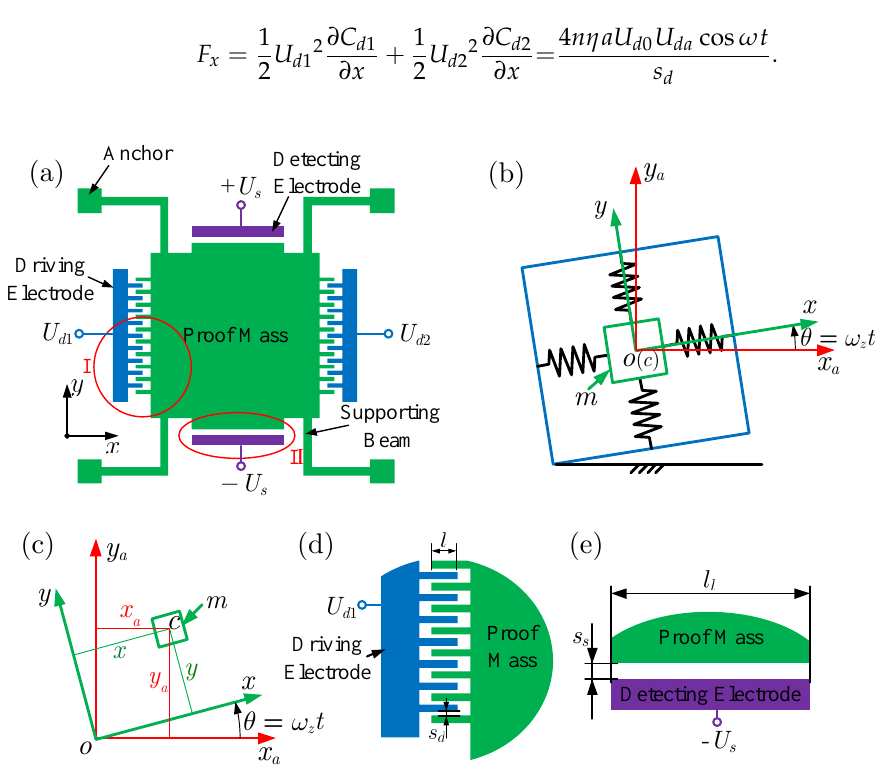
Figure 1. Model of the micro-machined gyroscope system. ( a ) The schematic representation of the micro-machined gyroscope. ( b ) Model of the gyroscope as a spring-mass system. ( c ) The relations between the displacements of the driving/detecting coordinate system and the inertial coordinate system. ( d ) The enlargement of I in Figure 1a: the driving structure. ( e ) The enlargement of II in Figure 1a: the detecting